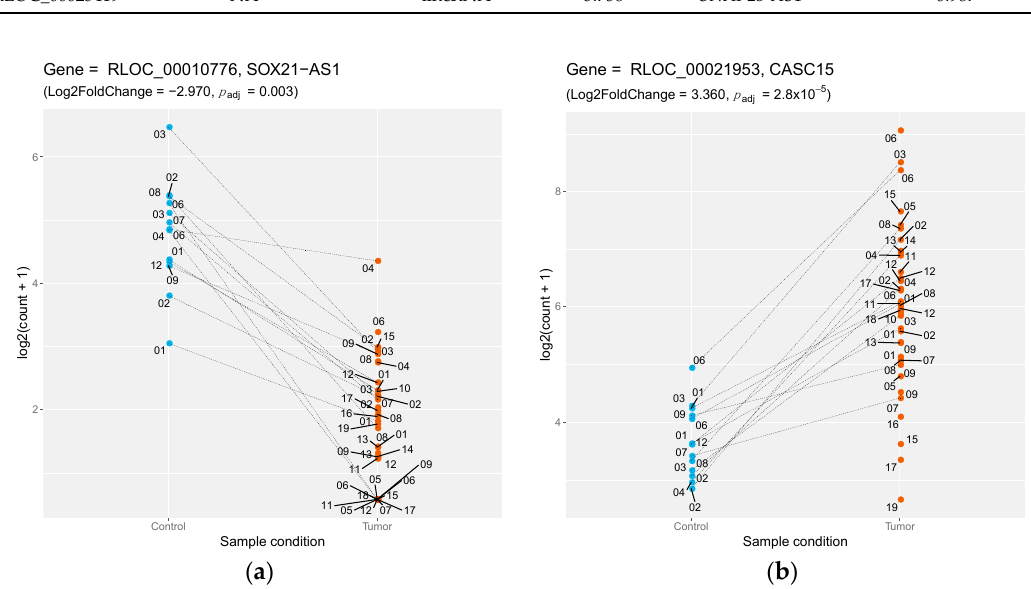
Figure 2. Differential expression of dog–human-conserved lncRNAs. ( a ) Down-regulation of the SOX21-AS1 lncRNA between control samples (blue) versus tumor samples (orange), with the log2 of normalized counts on the y -axis; lines connect matched samples from the same individuals. ( b ) Same representation for the up-regulation of the lncRNA CASC15 . Table 1. List of DE lncRNAs conserved with human GENCODE non-coding genes. Genes are ordered by ascending log2-fold change (lFC).